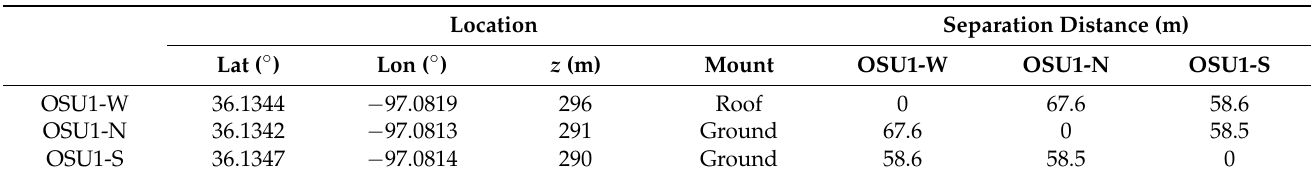
Figure 1. ( a ) Satellite image of the OSU1 infrasound array with each microphone labelled and denoted by the white X-pattern, which nominally marks the porous hose windscreen configurations (Source: Apple Maps). ( b ) Picture of OSU1-W mounted within the white acrylic dome and porous hoses extending from the sensor. ( c ) Picture of OSU1-S with the dome opened to show the sensor.